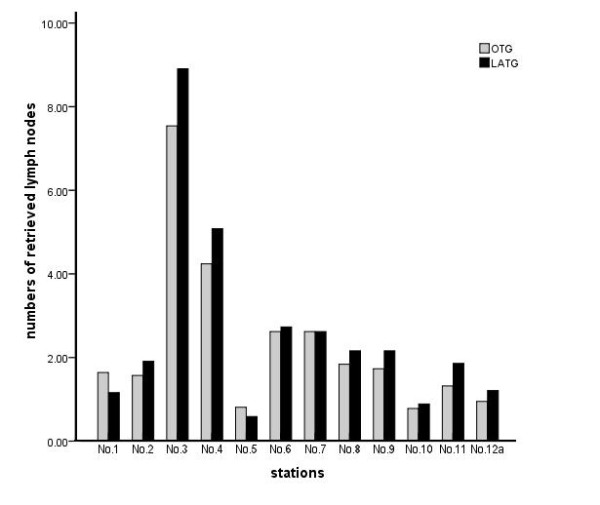
The retrieved lymph nodes from laparoscopy-assisted total gastrectomy (black bar) and open total gastrectomy (gray bar). There was no significant difference in the numbers of retrieved lymph nodes at each station.